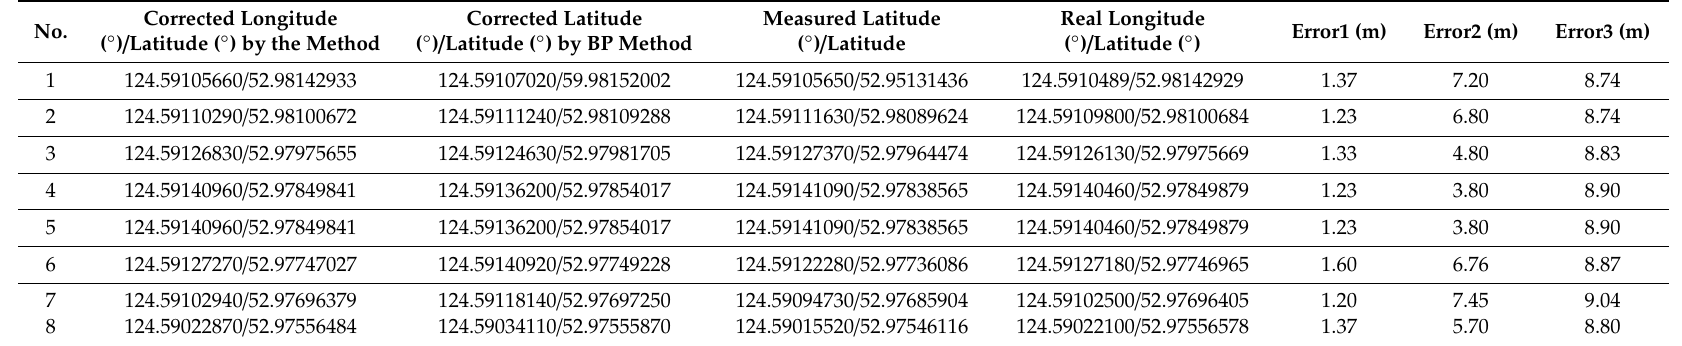
Table 3. Errors between the measured centerline obtained by di ff erent methods and the actual